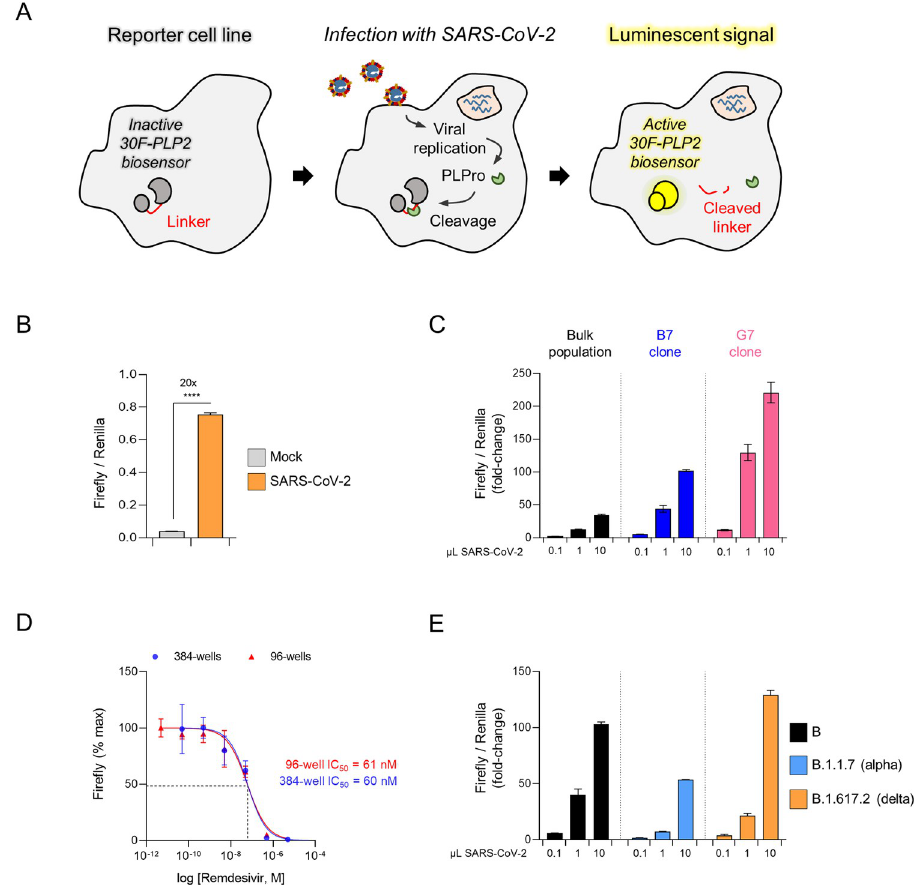
Fig 4. An optimised luminescent SARS-CoV-2 reporter cell line. ( A ) Schematic showing activation of luminescent reporter cell line by authentic SARS-CoV-2 infection. ( B ) Activation of reporter cells by SARS-CoV-2 infection. HEK293T-ACE2-30F-PLP2 cells (bulk population) were mock-infected or infected with SARS-CoV-2 at MOI = 0.01. ( C ) Selection of optimised cell lines. HEK2932-ACE2-30F-PLP2 cells (bulk population) or single-cell clones (B7 and G7) were mock-infected or infected with increasing doses of SARS-CoV-2. ( D ) Miniaturisation to 384-well plate format. Clone B7 reporter cells were infected with SARS-CoV-2 at MOI = 0.01 in the presence of decreasing doses of remdesivir in either a 96-well or 384-well plate format. Titration curves and IC50s for remdesivir are shown. Representative of 2 independent experiments. ( E ) Detection of SARS-CoV-2 variants of concern. Clone B7 reporter cells were mock-infected or infected with increasing doses of SARS-CoV-2 virus from the indicated lineages. Representative of 2 independent experiments. For C and E , 1 μ L of viral stock corresponds to MOI � 0.01 for the lineage B and B.1.617.2 (delta) viral isolates, and MOI � 0.005 for the lineage B.1.1.7 (alpha) viral isolate. For all experiments, Firefly and Renilla luciferase activities were measured by luminometry 24 h post-infection. Unless otherwise stated, mean values ± SEM are shown for experiments performed in triplicate, representative of at least 3 independent experiments. For C and E , Firefly/Renilla luminescence is shown as fold-change with/without infection. For D , Firefly luminescence is shown as % maximum. ���� p <